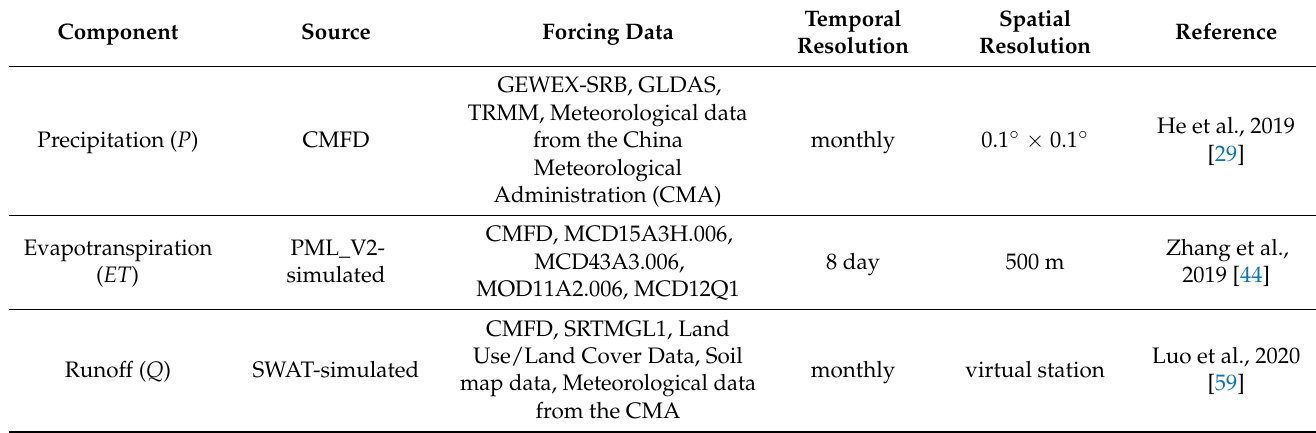
Table 1. Detailed water balance